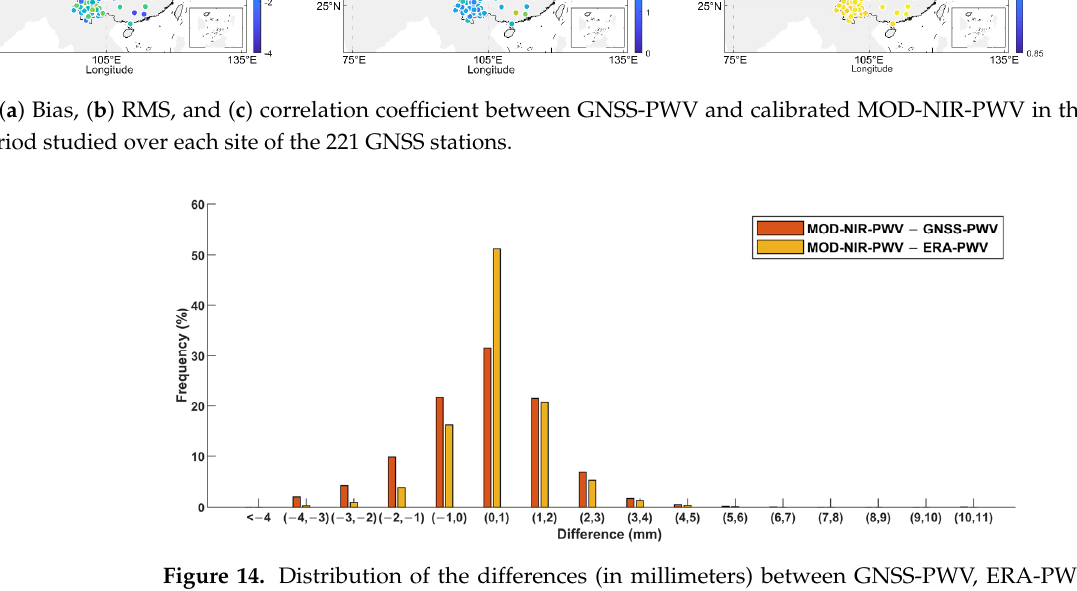
Figure 14. Distribution of the differences (in millimeters) between GNSS-PWV, ERA-PWV, and cal- ibrated MOD-NIR-PWV in the six-year period studied over China.